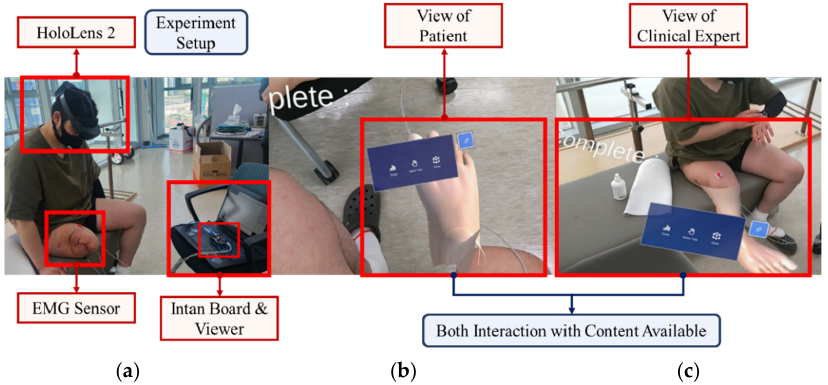
Figure 9. The Configuration of the Amputation Patient Actual Test Environment and the Viewpoint of the Participants in the Multi ‐ Session (( a ) = Experiment Setup, ( b ) = Patient’s Viewpoint, ( c ) = Clinical Expert’s Viewpoint).